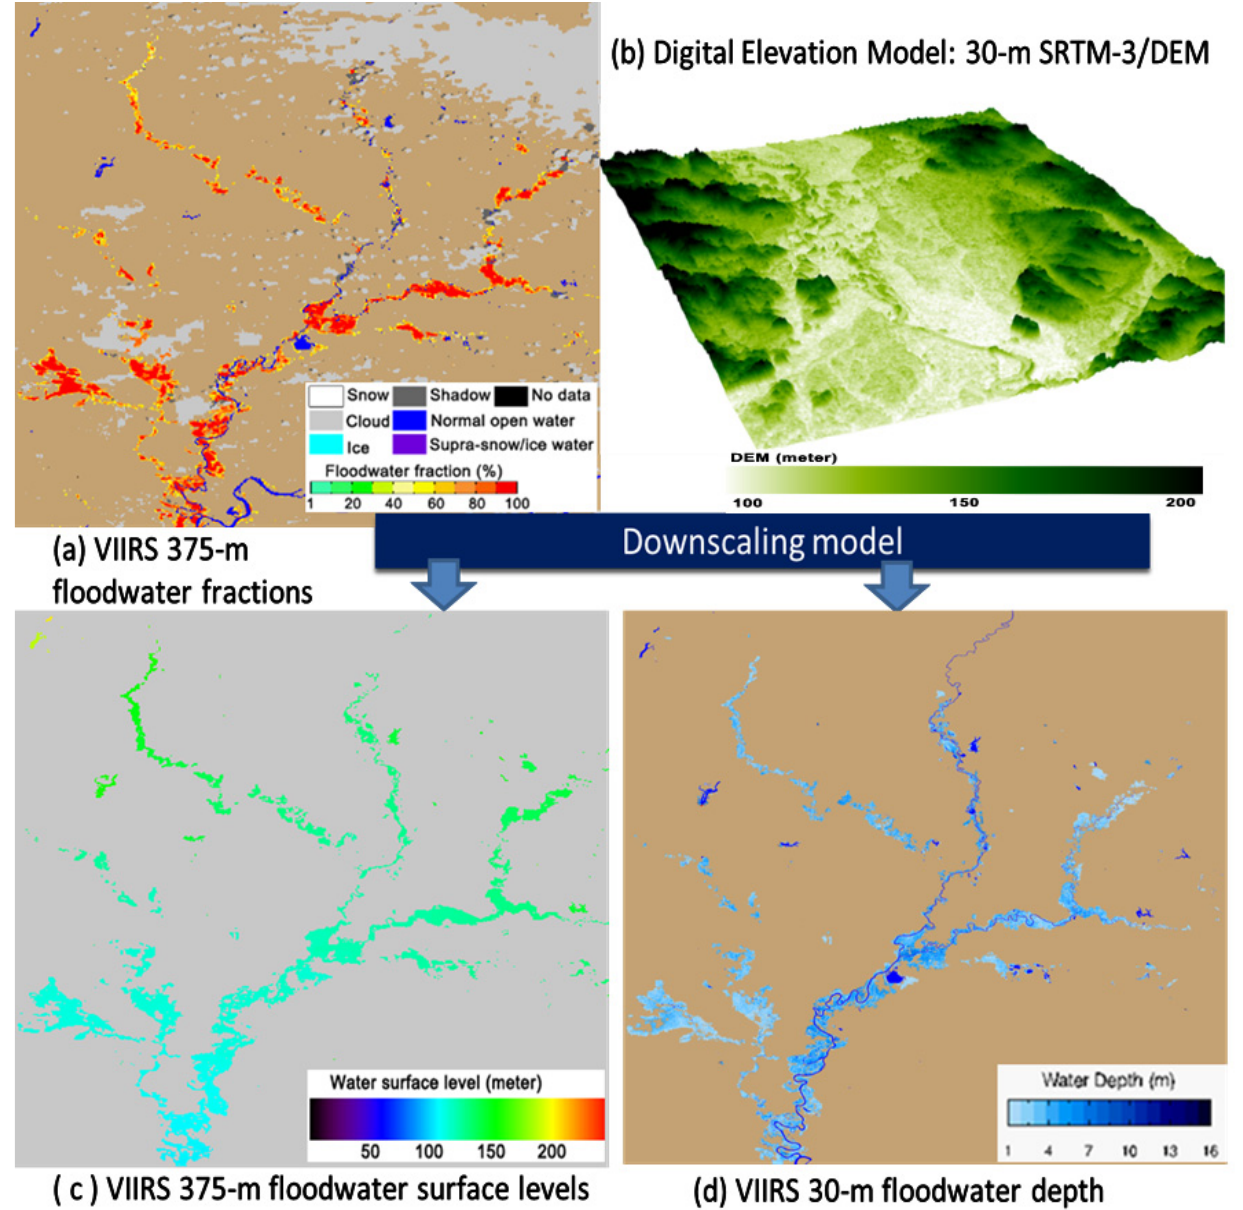
Figure 1. An example of VIIRS 3D flood products along the Ohio River Basin on 9 May, 2017: ( a ) VIIRS 375 m floodwater fraction map; ( b ) high-resolution DEM map; ( c ) VIIRS 375 m floodwater surface level map; and ( d ) VIIRS 30 m floodwater depth map.